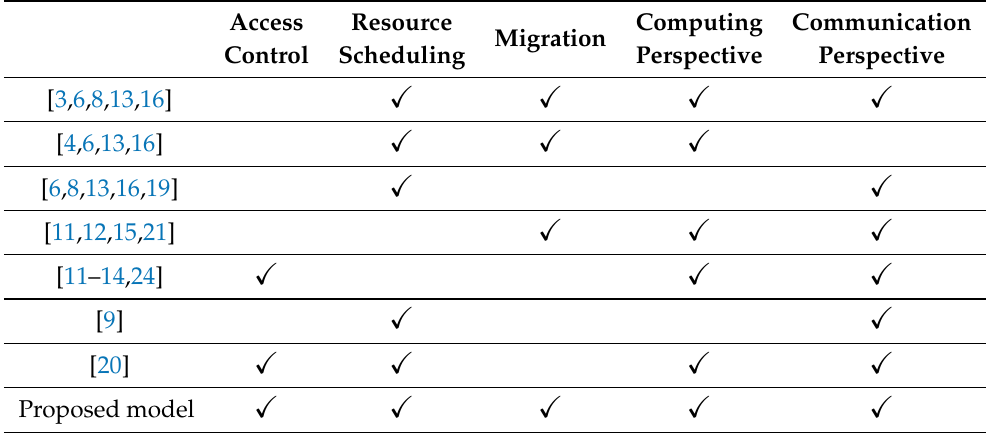
Table 1. Proposed model comparisons with literature.